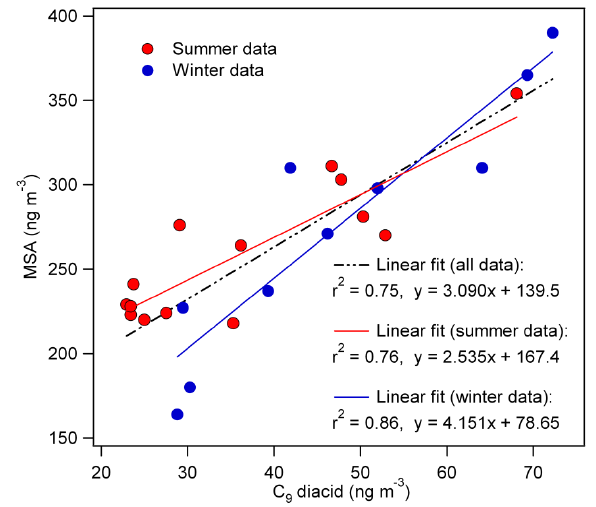
Fig. 3. Five-day backward trajectories obtained for each of the samples. The analysis was performed using the HYSPLIT4 model (http://www.arl.noaa.gov/ready/hysplit4.html, NOAA Air Resources Laboratory, Silver Spring, Maryland, United States). These trajectories were calculated for air masses starting from the sampling site (with sampling ending time) at 1000m height using the model vertical velocity and reanalysis data. The flow pattern was updated every 6h.